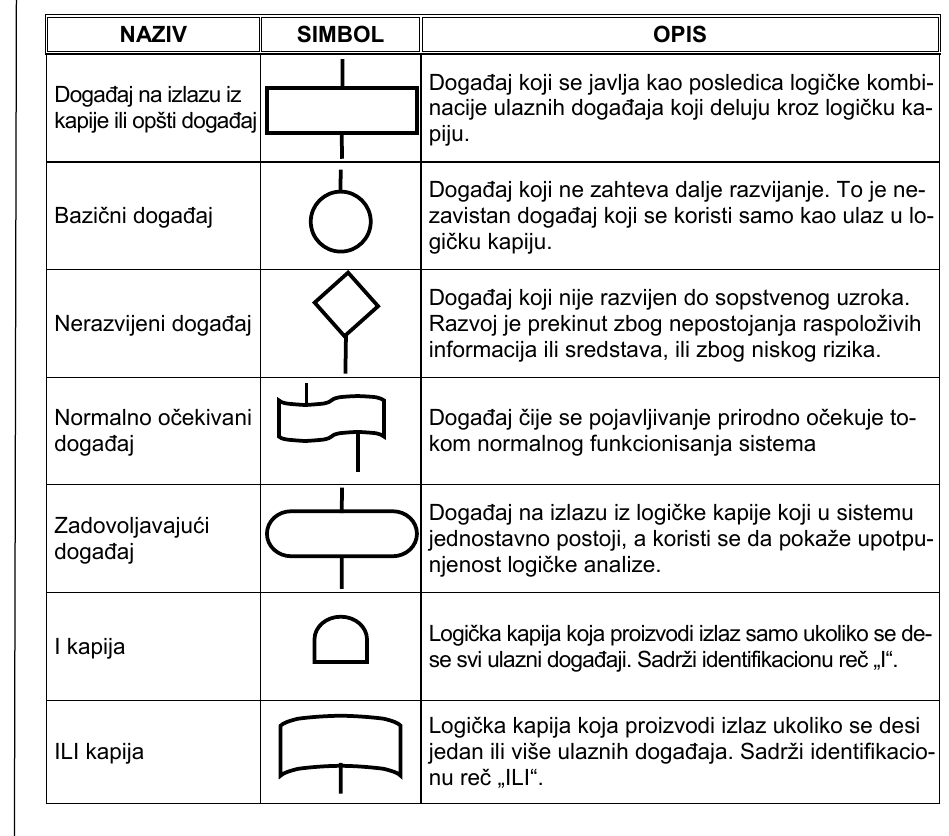
Standardni simboli FTA